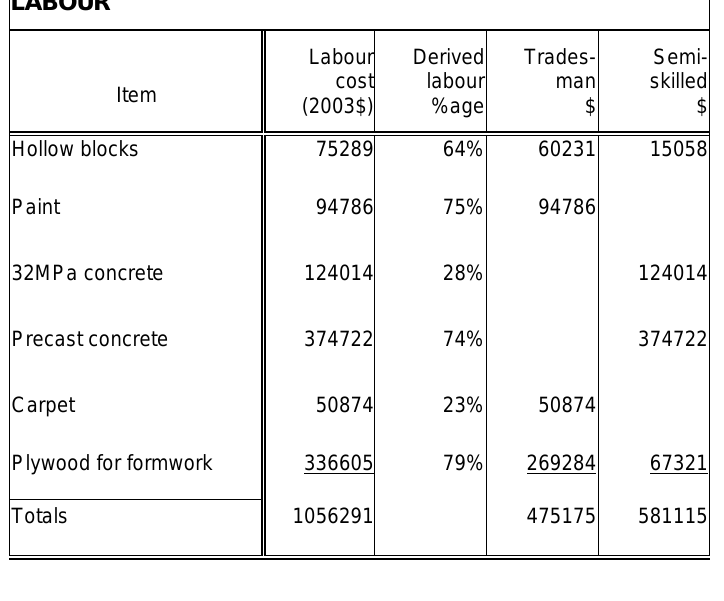
Table 2: Calculation of labour costs